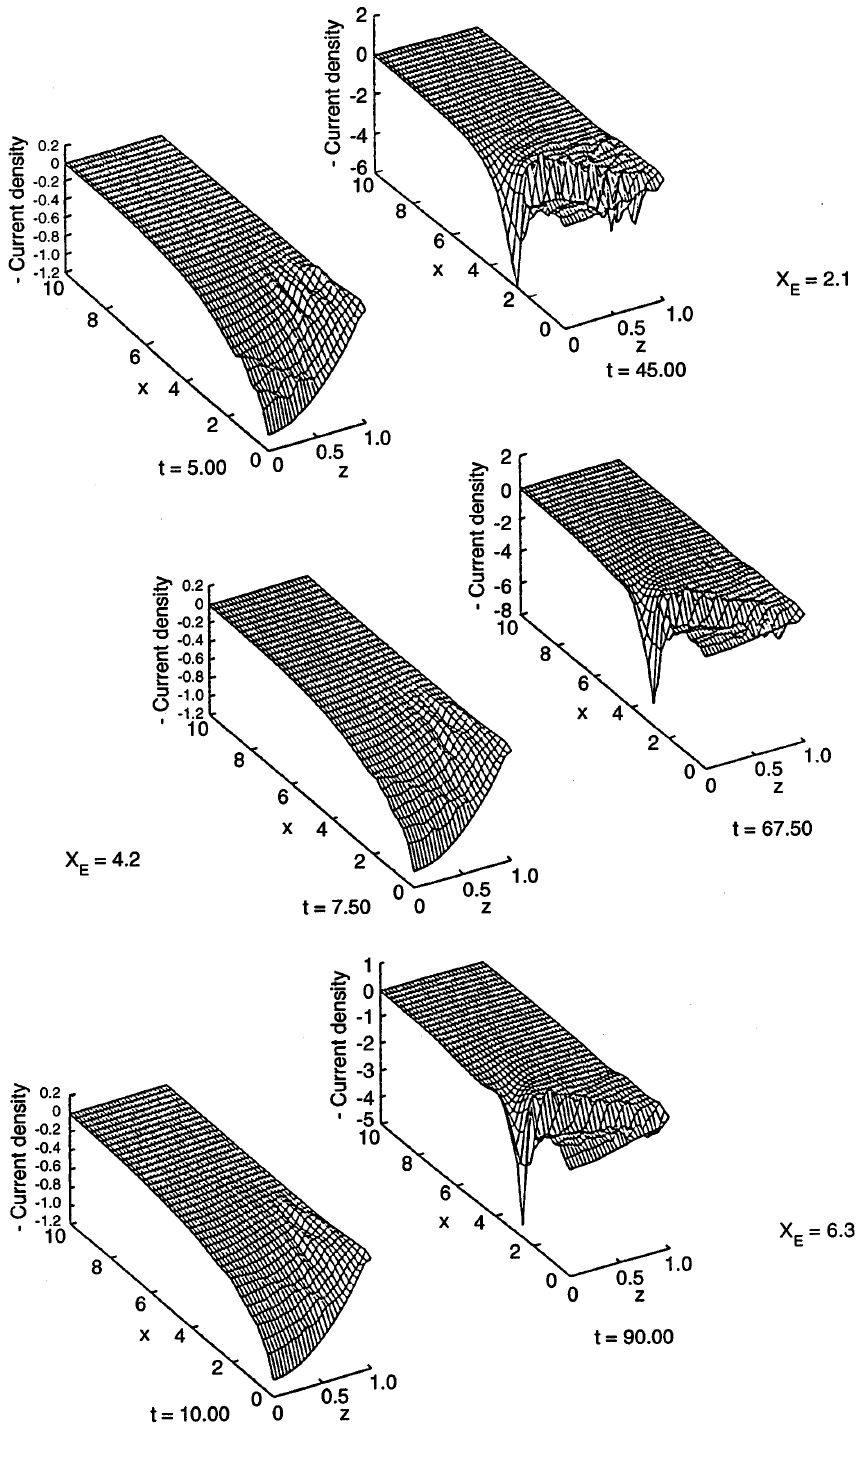
Fig. 4. 2-dimensional simulation of cur- rent sheet formation. Surface plots of the current densities for the cases 1–3 in an early phase of the dynamics (after 5 s A (case 1), 7 : 5 s A (case 2) and 10 s A (case 3)) and in a later phase (after 45 s A (case 1), 67 : 7 s A (case 2) and 90 s A (case 3)). In all three cases thin current sheets develop near x (cid:136) 3 corresponding to about 8–10 R E tailwards